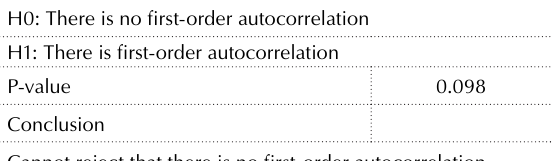
Table 6. Results of the Wooldridge test